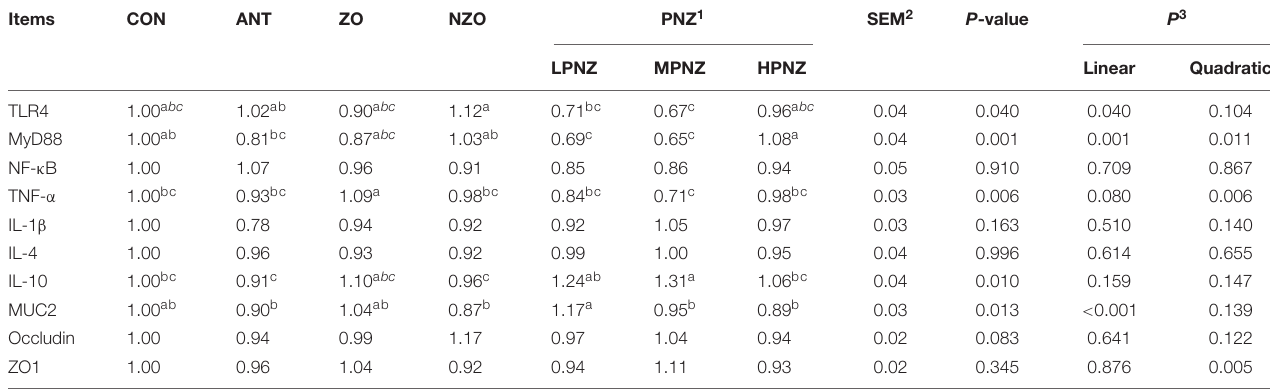
TABLE 8 | Effects of PNZ on the mRNA expression of ileal mucosa of weaned pigs.